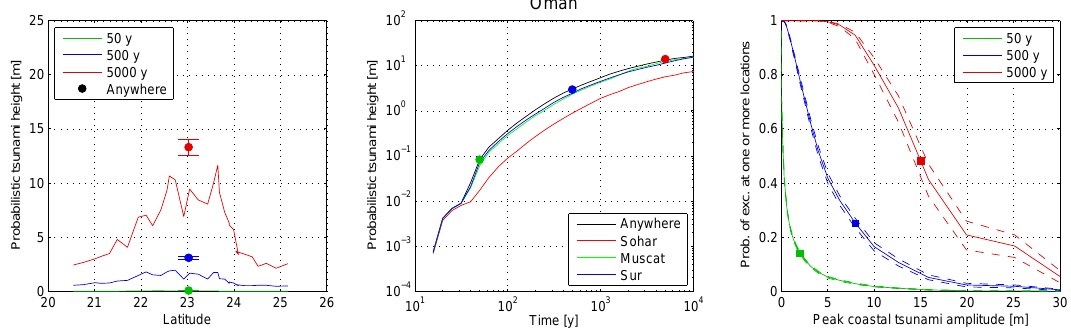
Figure 4. Same as Fig. 3 but for the exposed coastline of